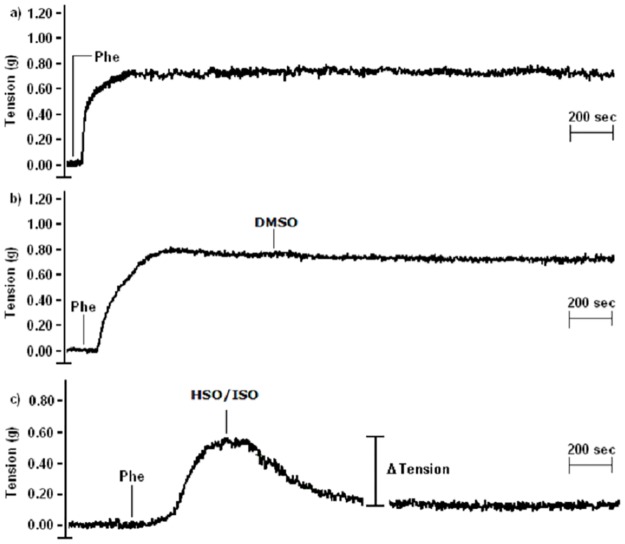
The effect on the tension force of rat aortic rings induced by vasoactive substances.a) Phenylephrine (Phe) promoted vasoconstriction, b) DMSO did not exert an effect, and c) either HSO (hydrolyzed shark oil) or ISO (isomerized shark oil) induced vasorelaxation. Tension, in grams (g), was considered an index of the vascular tone. Recordings are representative of three independent experiments.